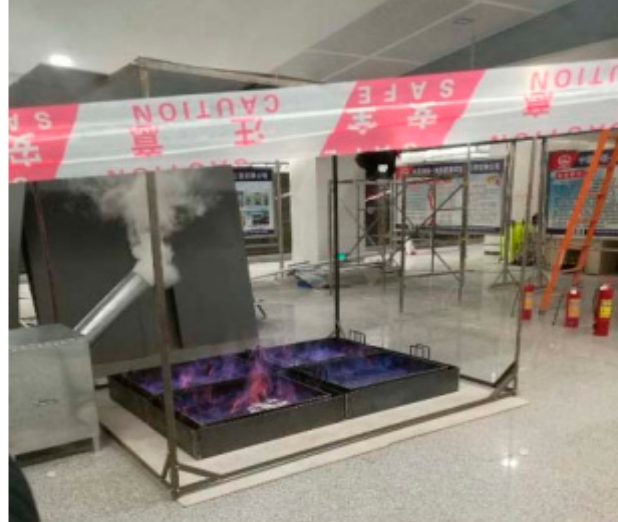
Figure 11. Diesel Pan of 1.82 m 2 . Table 12. Smoke scene Y1 modeling.